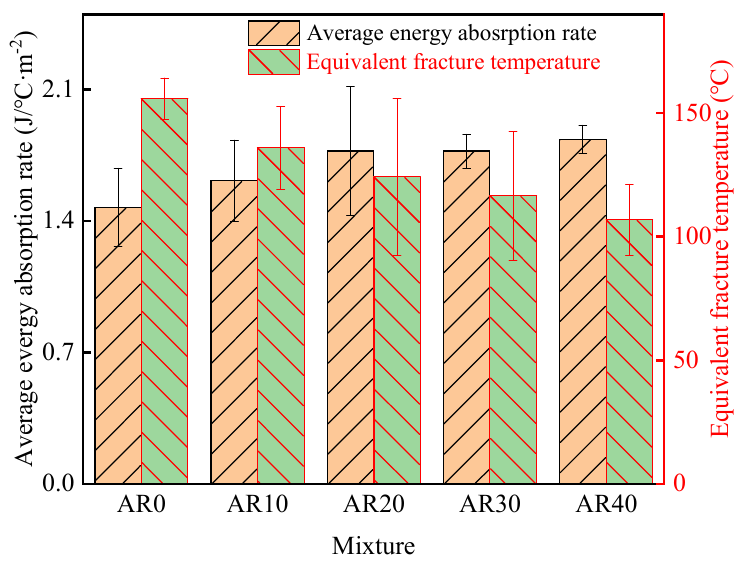
Figure 8. EAA and EFT of various mixtures.